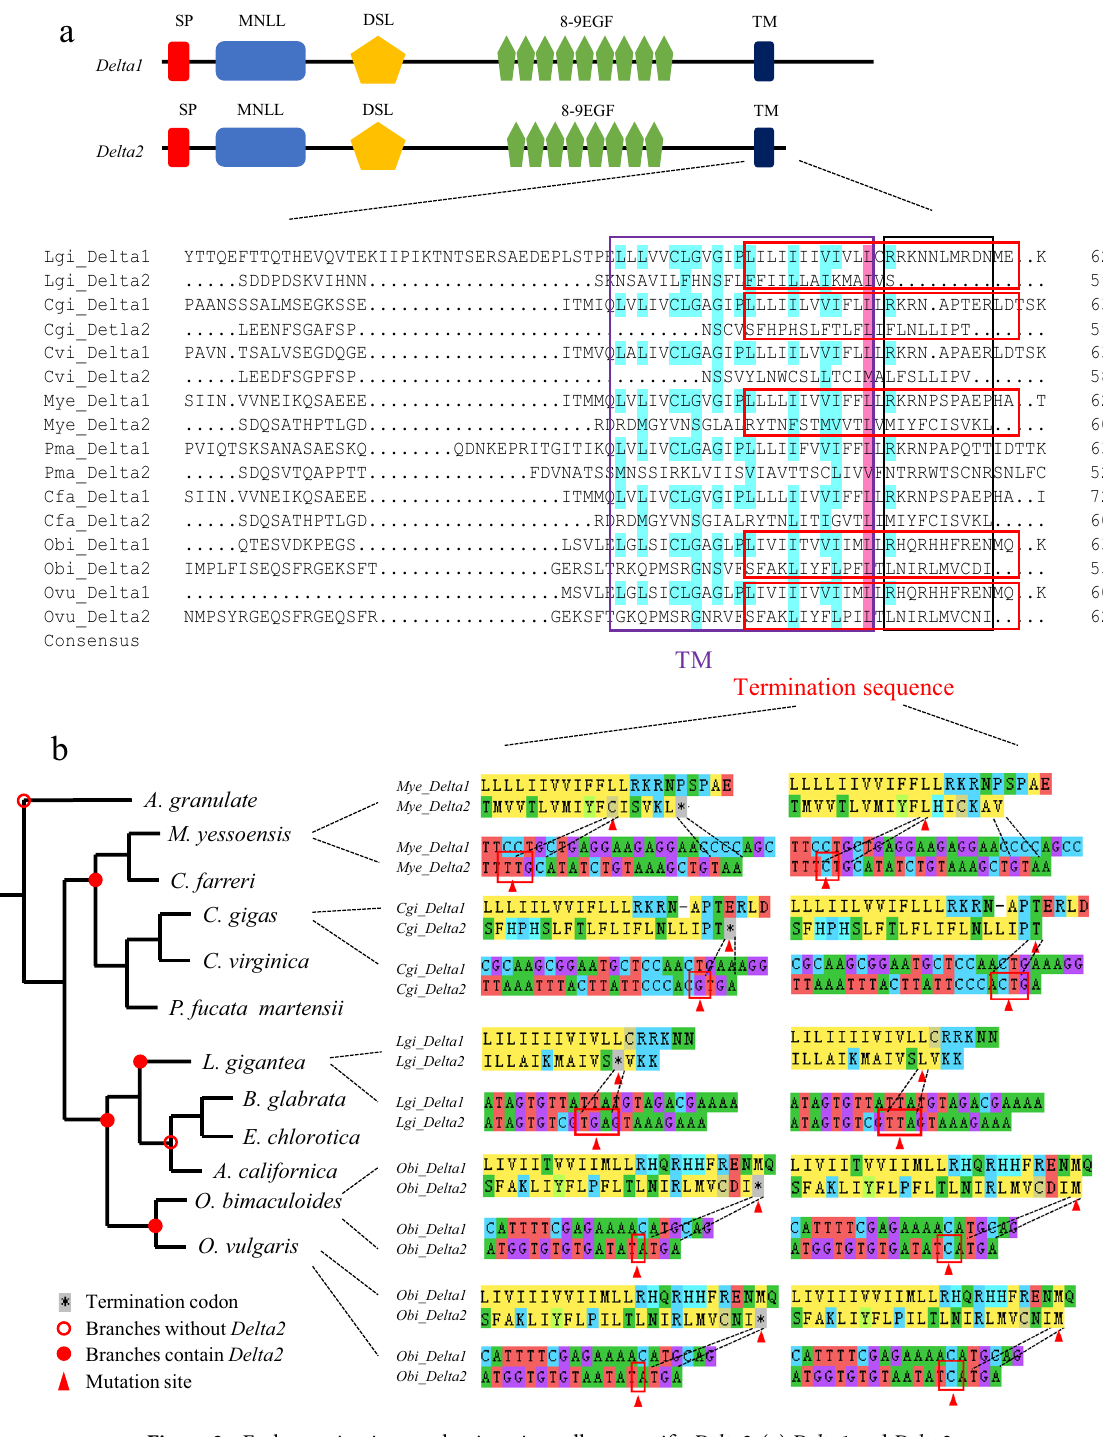
Figure 3. Early termination mechanisms in mollusc-specific Delta2 . ( a ) Delta1 and Delta2 gene structures and blast (DNAMAN) results. The protein sequences indicated in the purple frame are TM domains whereas those indicated in the black frame are common termination positions for Delta2 . The sequences in the red frame were analysed in detail in ( b ). ( b ) Delta2 termination mechanisms in different molluscs. Red solid circles indicate branches containing Delta2. Red hollow circles indicate no Delta2 . Both amino acid and nucleotide sequences are displayed here, and the left column includes the termination sequences in lophotrochozoan species whereas the right column denotes sequences after correction. The colours of amino acids represent the functions of codons; amino acids of the same colour have similar functions. The same colour nucleotide represents the same base. The amino acids with a dashed line corresponding to bases in the red frames and triangles represent mutation codon sites in Delta2 . “*” means termination codon. MEGA X was used for visualizing mutation